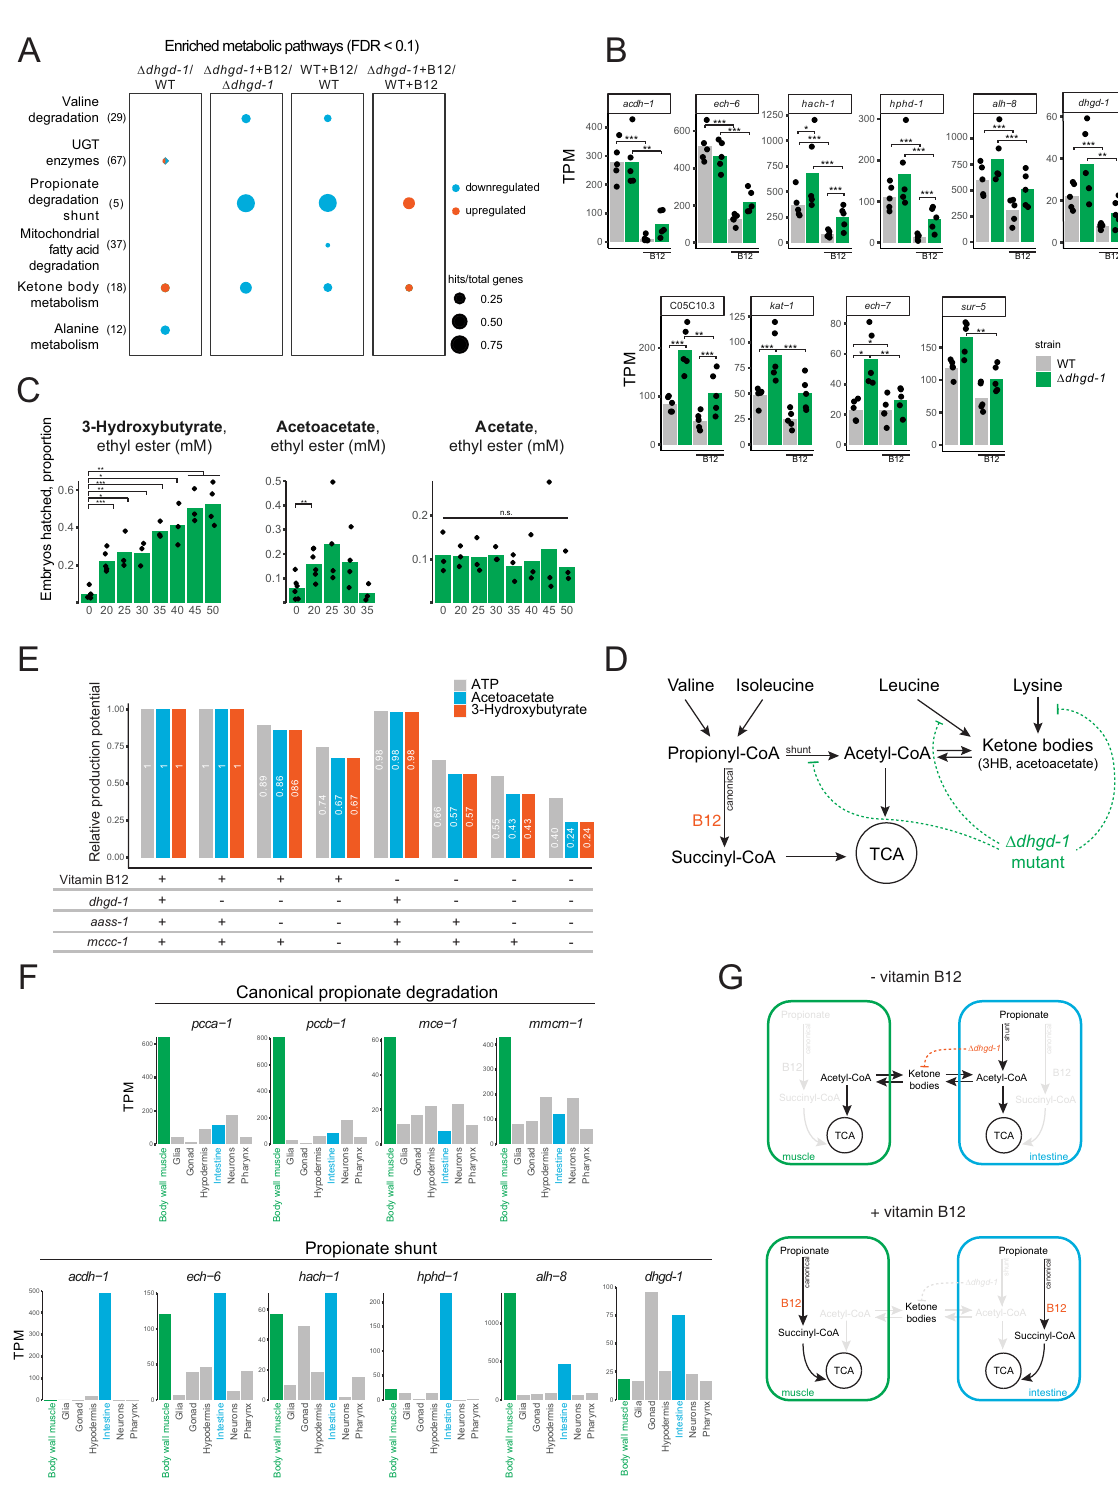
Fig 4. Loss of dhgd-1 activates the expression of ketone body metabolism genes. (A) Gene expression pathway enrichment analysis for animals with and without vitamin B12 (B12). (B) RNA-seq data for propionate shunt (top) and ketone body metabolism genes (bottom). TPM–transcripts per million. Gene categories were annotated in [35]. (C) Supplementation of 3HB or AA ethyl esters partially rescues lethality of Δ dhgd-1 mutant animals. Acetate ethyl ester was used as a negative control. (D) Model for the effect of dhgd-1 mutation on ketone body production.